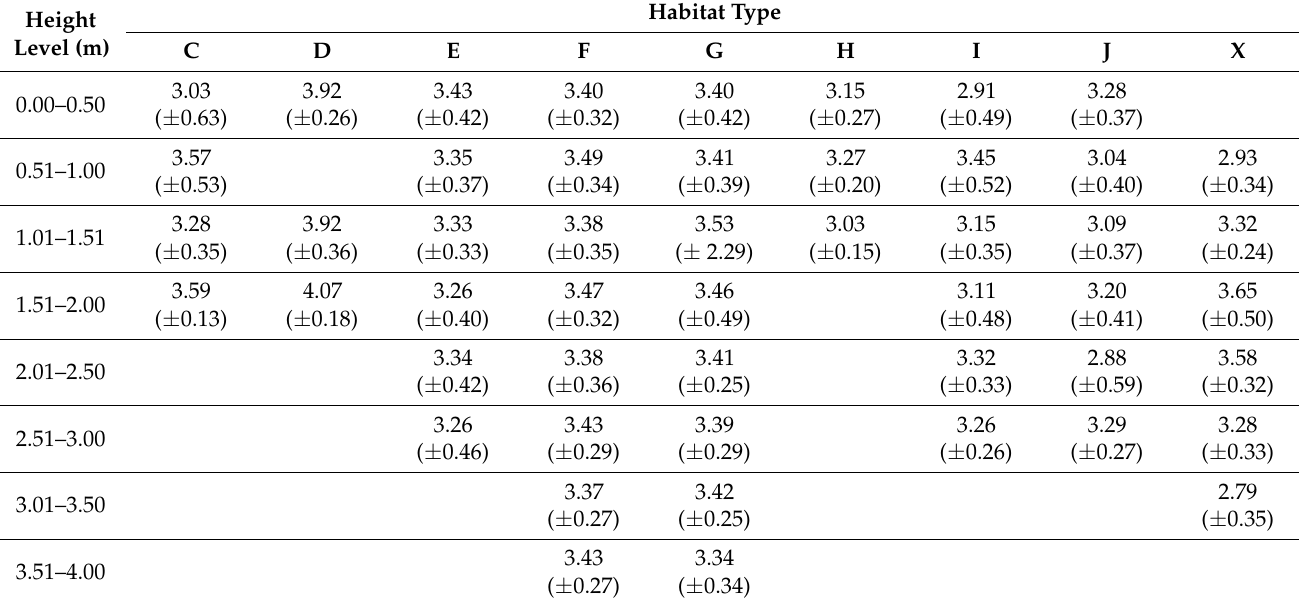
Table 7. The width (cm) of the fruits (mean ± SD) of Echinocystis lobata at different height levels in inland surface waters (C); mires, bogs, and fens (D); grasslands and lands dominated by forbs, mosses, or lichens (E); heathland, scrub, and tundra (F); woodland, forest, and other wooded land (G); inland unvegetated or sparsely vegetated habitats (H); regularly or recently cultivated agricultural, horticultural and domestic habitats (I); constructed, industrial, and other artificial habitats (J); habitat complexes (X).